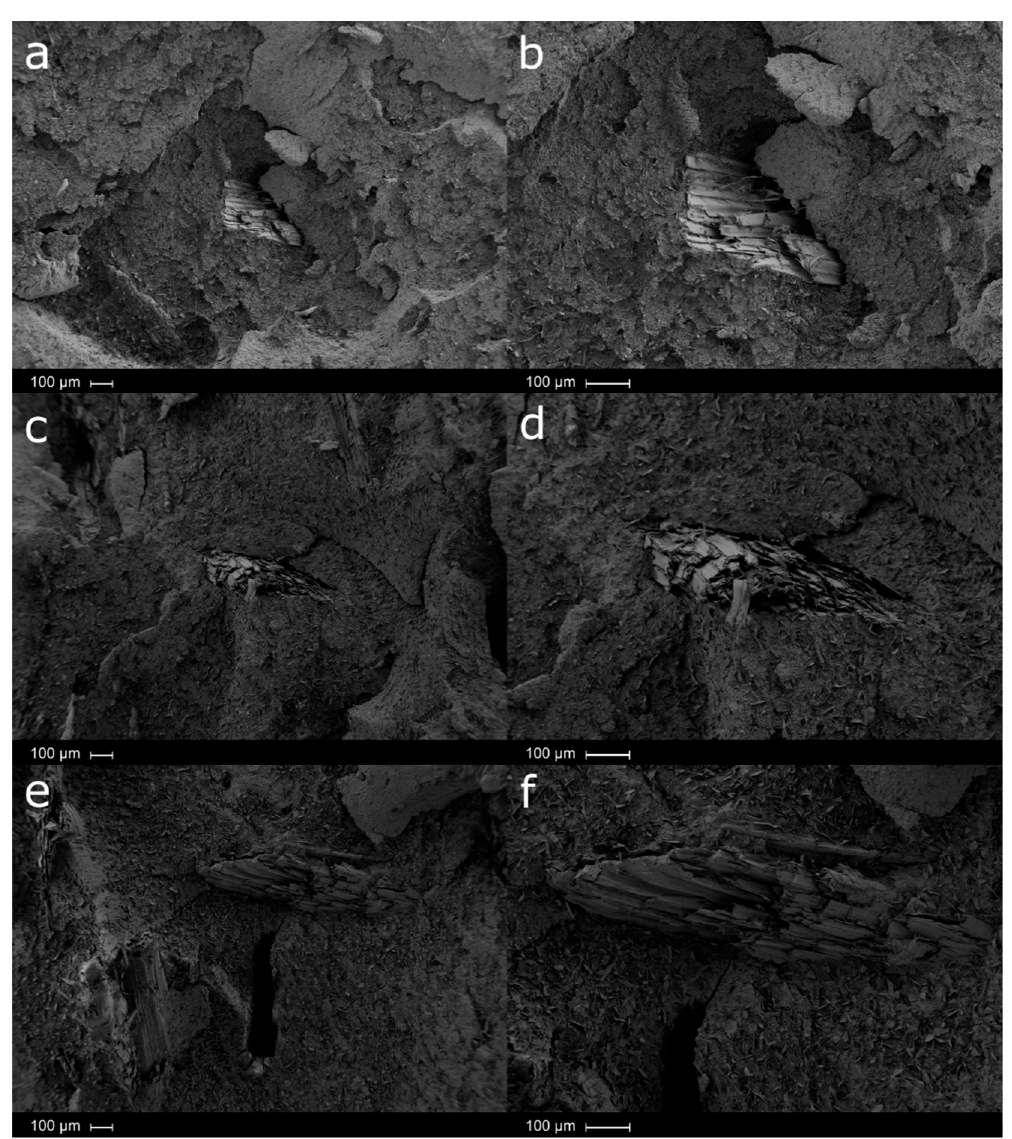
Figure 13. SEM micrographs of largest sized particles, Grade 9—10 wt.% wood flour: ( a ) ×50, ( b ) ×100; Grade 9—20 wt.% wood flour: ( c ) ×50, ( d ) ×100; and Grade 9—30 wt.% wood flour: ( e ) ×50, ( f ) ×100.